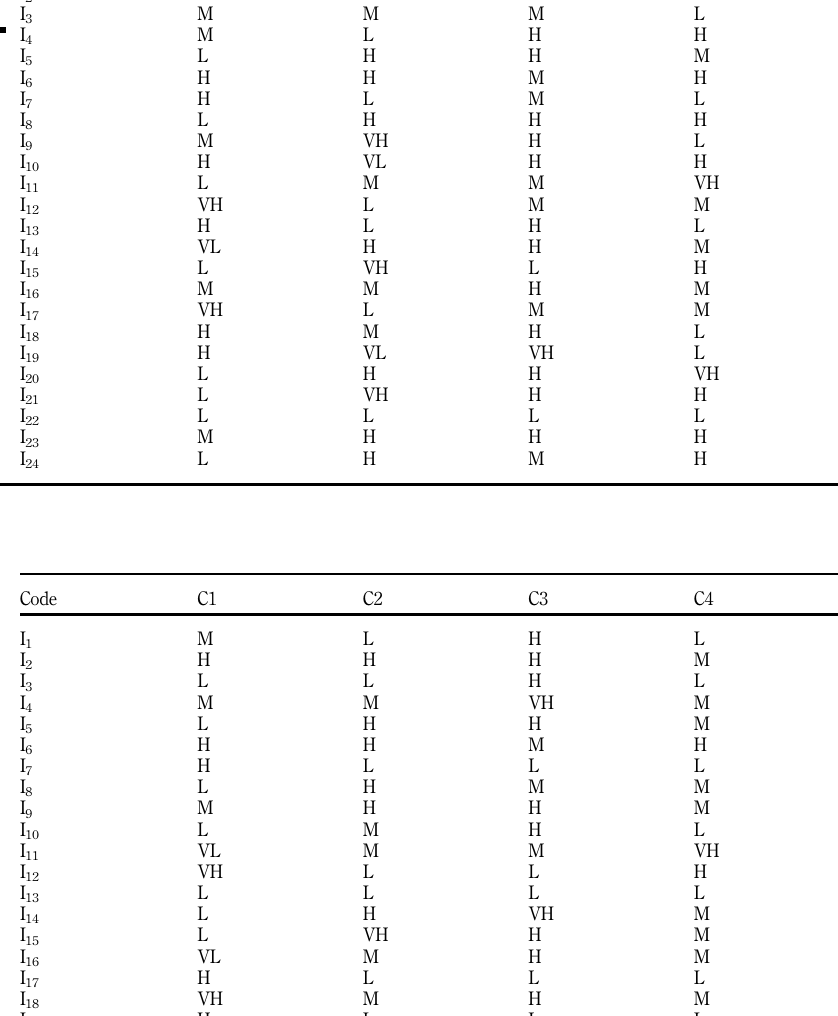
Table A2. Linguistic